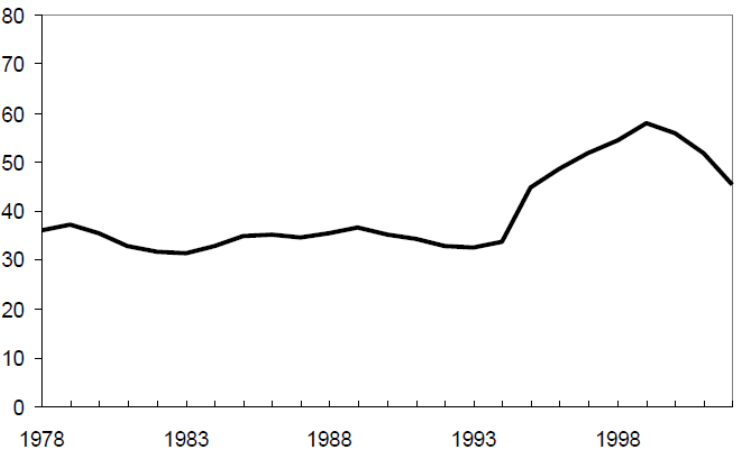
Figure 2. Average Capital/Asset Ratio of Non-Financial Companies Europe 1978–2002.